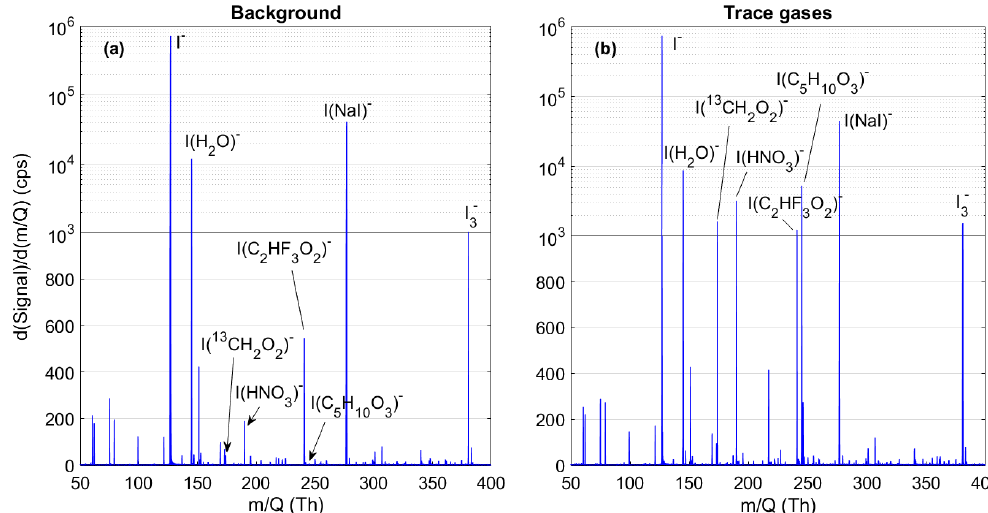
Figure 7. High-resolution mass spectra collected when sampling (a) UHP N 2 and (b) UHP N 2 containing HNO 3 , H 13 COOH, and IEPOX